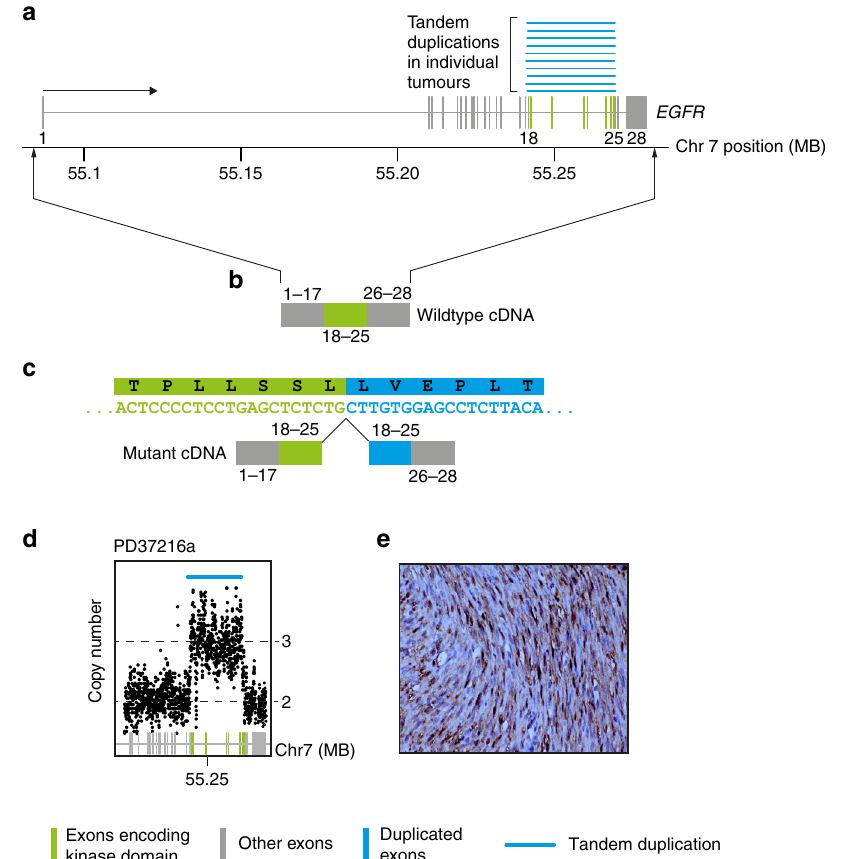
Fig. 1 EGFR internal tandem duplication. a The genomic footprint of EGFR is depicted with exons represented by gray and green vertical lines. Green exons encode the kinase domain. Blue lines superiorly show the tandem duplications found in the discovery cohort of ten congenital mesoblastic nephroma of classical histology. b Schematic of the wild-type transcript. c Schematic of the fusion transcript annotated with cDNA sequence of rearrangements (sense orientation) and protein translation. d Intragenic copy number of EGFR showing focal ampli fi cation over the kinase domain ( x -axis: genomic coordinate; y -axis: copy number derived from coverage). e Representative phospo-ERK